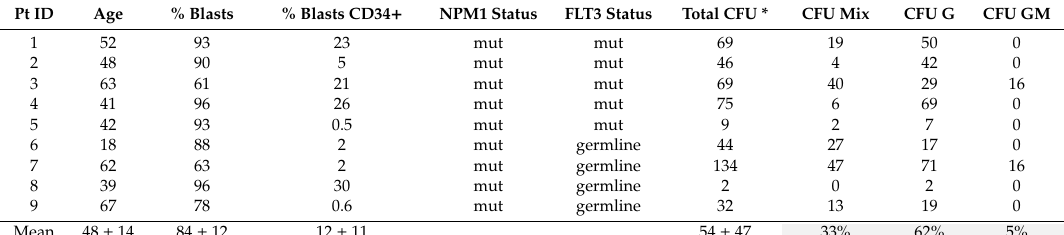
Table 1. Clonogenic capacity of BM cells from NPM1 -mutated AML patients.